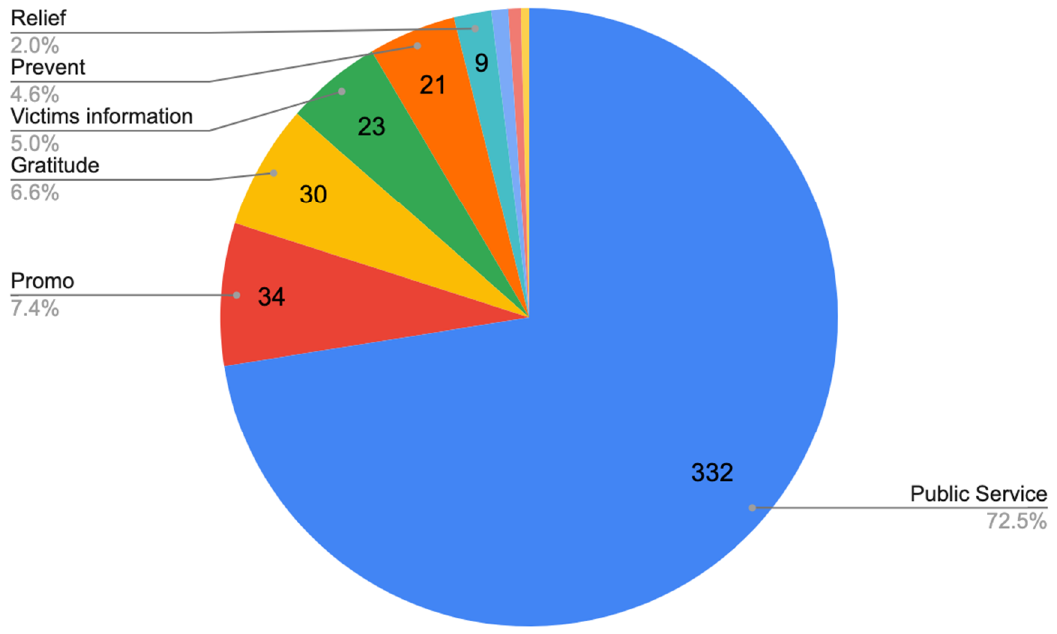
Figure 7. Tweets by qualifier. Source: own elaboration.